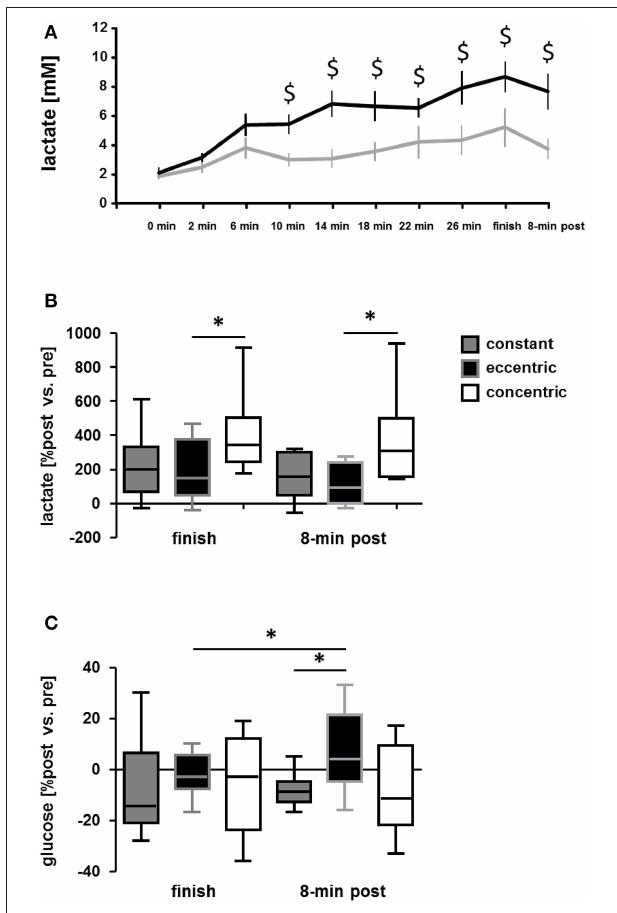
FIGURE 6 | Differences in alterations of serum metabolites between the exercise protocols. (A) Line graph showing the mean + SE of blood lactate concentration during the course of matched concentric and eccentric type of interval exercise on the soft robot. (B,C) Box Whisker plots showing the baseline-differences in blood lactate (B) and glucose (C) concentration immediately and 8 after finishing concentric and eccentric interval exercise on the soft robot or endurance exercise at constant load. * p < 0.05 for the indicated comparison. Repeated ANOVA for the repeated factor of the exercise being performed (constant, eccentric, concentric) with post-hoc test for least significant